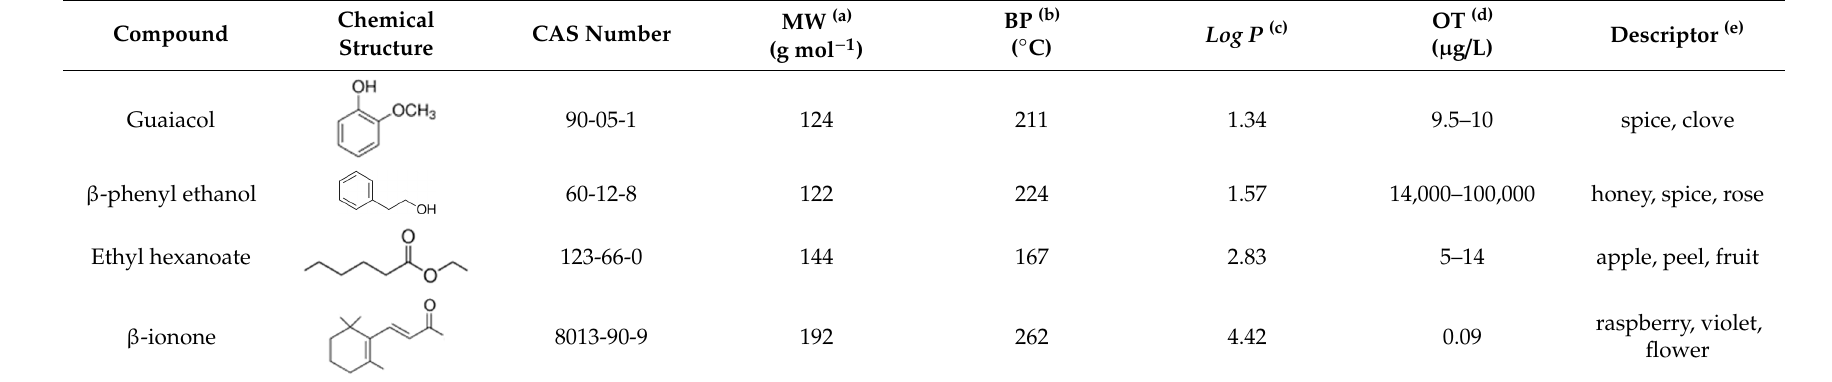
Table 1. Structure and physicochemical properties of the aroma compounds employed in this study.